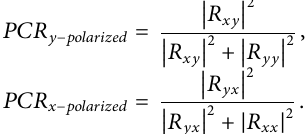
Based on Figure 3 , the co-polarized re fl ectance coef fi cients for